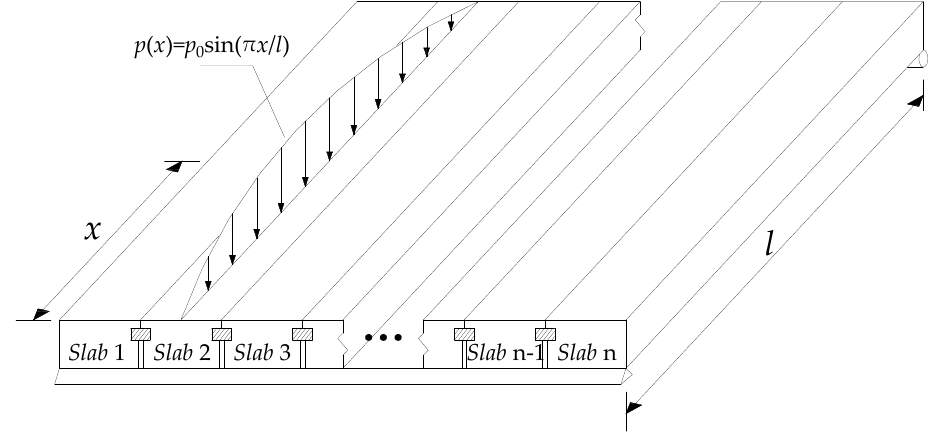
Figure 2. The force diagram of simply supported hinged-slab bridge.